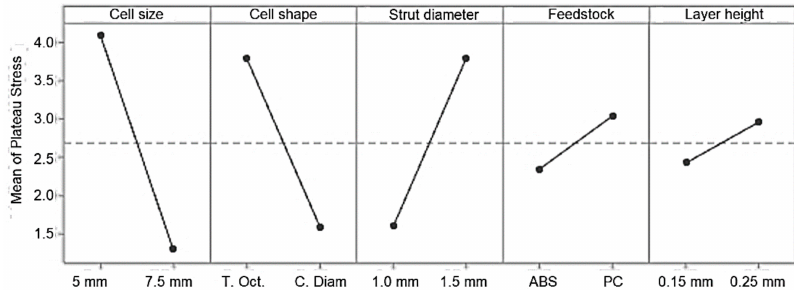
Figure 6. Main effect plots for plateau stress, σ pl .